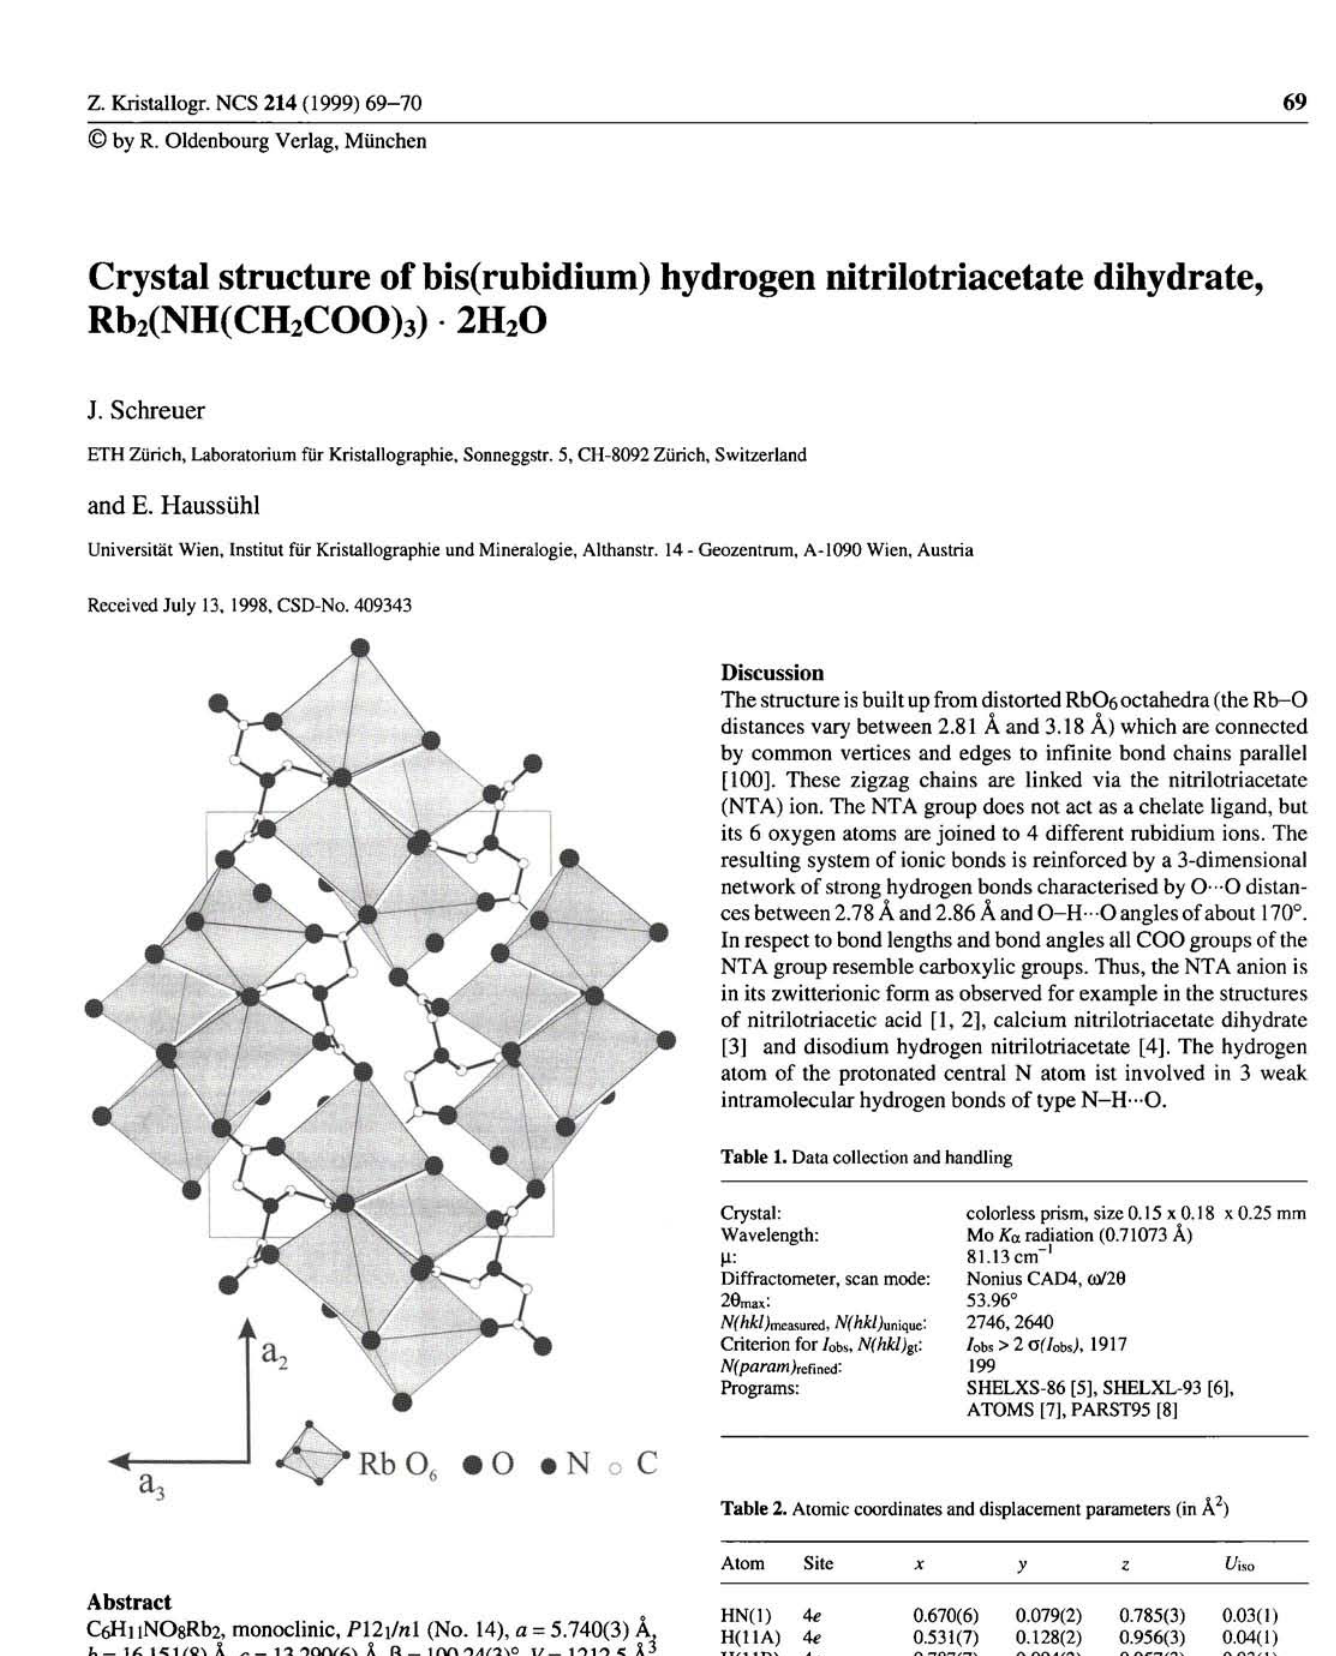
Table 2. Atomic coordinates and displacement parameters (in Â 2